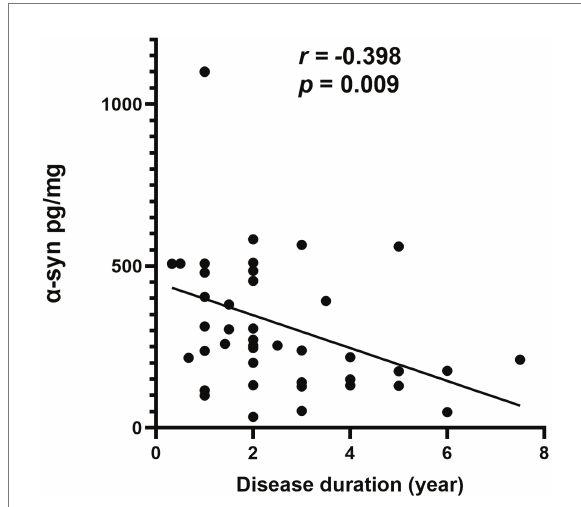
FIGURE 4 Correlation of α -syn in oral mucosa with disease duration in patients with MSA.